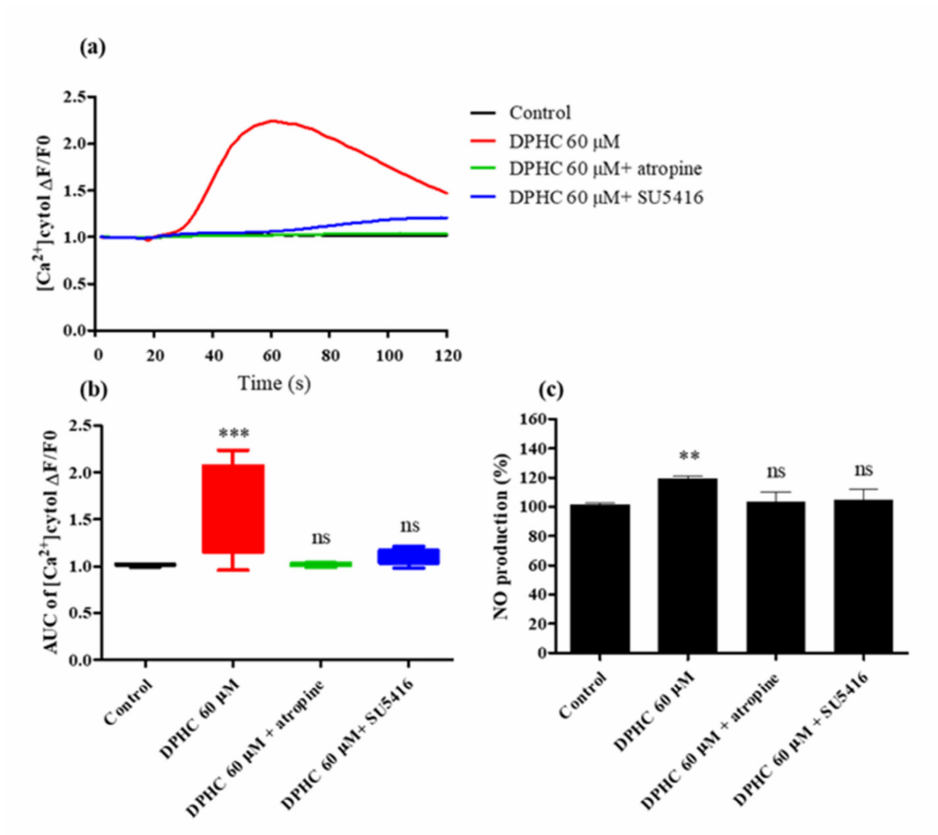
Figure 5. Influence of specific antagonists on [Ca2+] cytol levels in EA.hy926 cells treated with DPHC. ( a , b ) Traces ( a ) and box plots ( b ) indicating [Ca2+] cytol levels in response to treatment with DPHC (60 µ M) and antagonists. ( c ) Effect of DPHC on NO production in EA.hy926 cells pretreated with atropine or SU5416. The NO levels were detected by adding 10 µ M of 4 amino-5-methylamino-2 (cid:48) , 7 (cid:48) -difluorescein diacetate (DAF-FM DA). Experiments were performed in triplicates. Each column and bar represent the mean ± standard deviation (S.D.). ** p < 0.01. *** p < 0.001, significant difference compared to the control group. ns: not significant; AUC: area under the curve; DPHC: diphlorethohydroxycarmalol; [Ca2+] cytol : calcium level in the